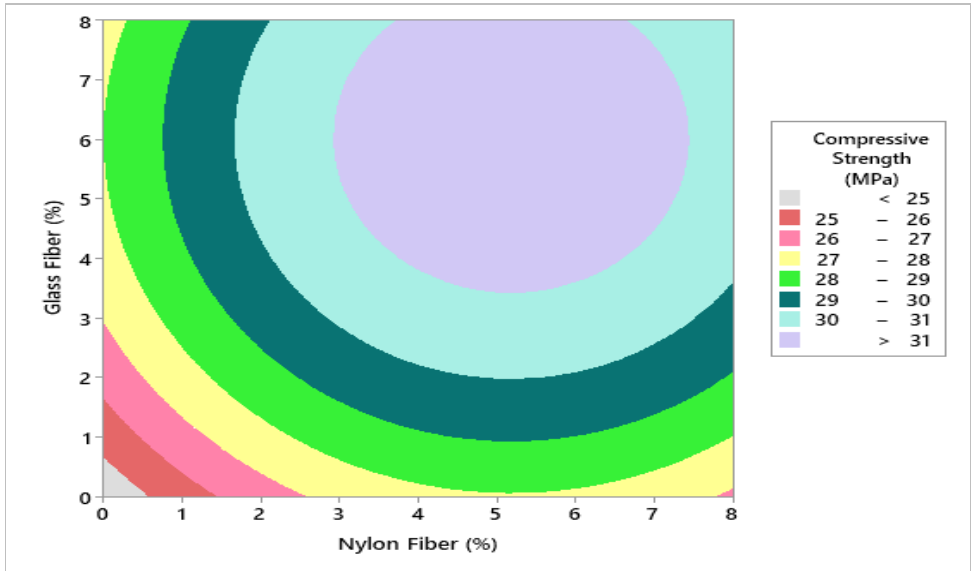
Figure 6. Three-dimensional response surface for compressive strength (MPa).